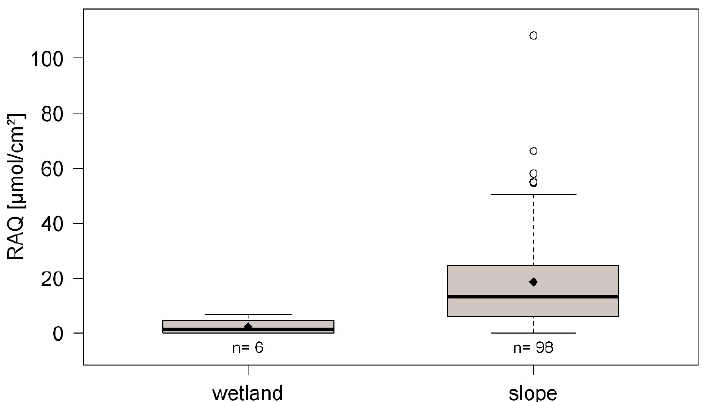
Figure 13. Seasonal potentially bio-available nitrate as captured by the ion-exchange resins at the wetland fringe and at the upland wetland fringe and at the upland positions.